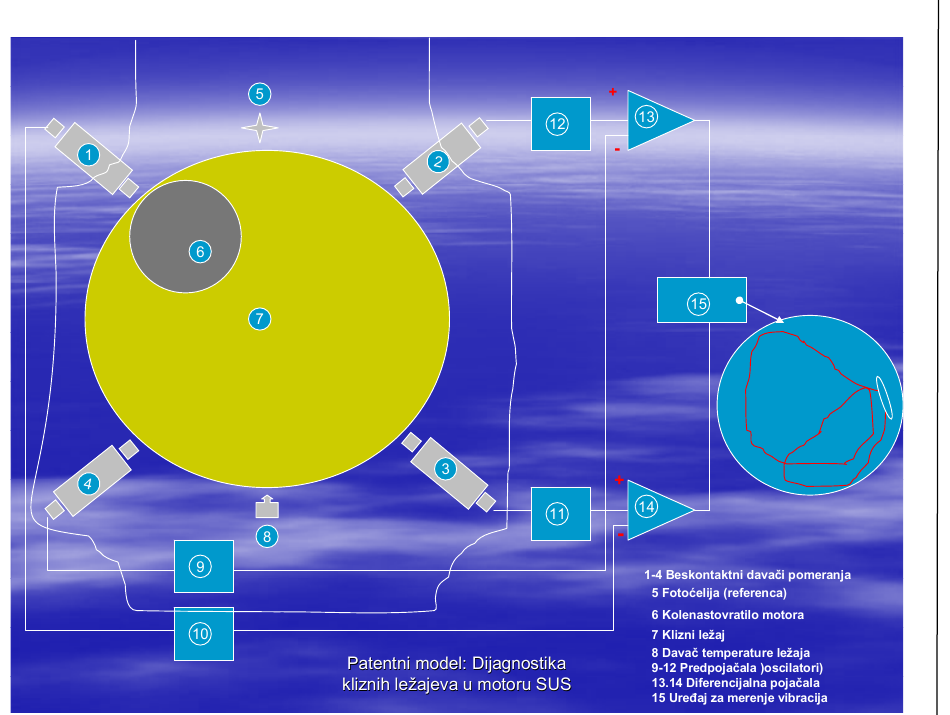
Slika 2 – Prikaz monitoring sistema kliznih ležajeva Рис . 2 – Изображение системы мониторинга подшипников скольжения Figure 2 – Plain bearings monitoring